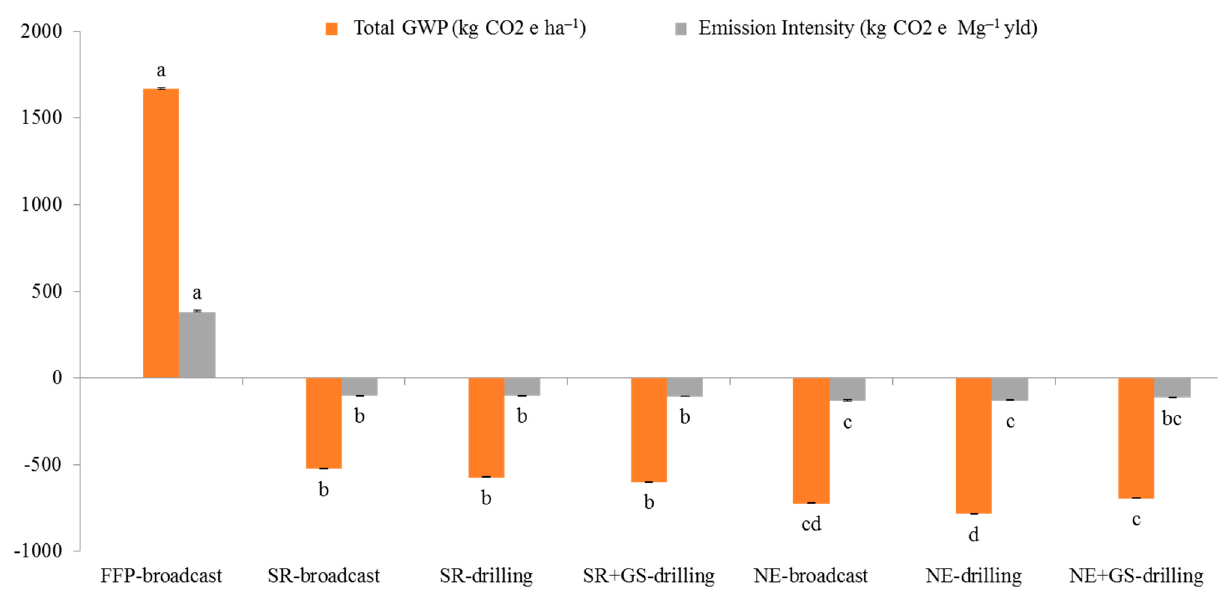
Figure 6. Global warming potential (GWP) and greenhouse gases intensity (GHGI) of maize-wheat system under different fertilizer management strategies. Vertical bar shows standard error of the mean. Refer Table 2 for details of nutrient management treatments. Values with different lower case (a–d) letters are significantly different between each nutrient management treatments at LSD 0.05.